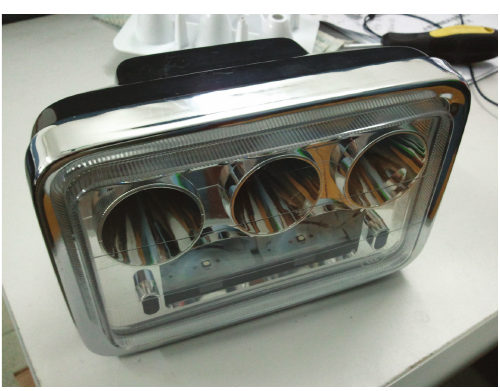
Figure 11: Assembled motorbike’s